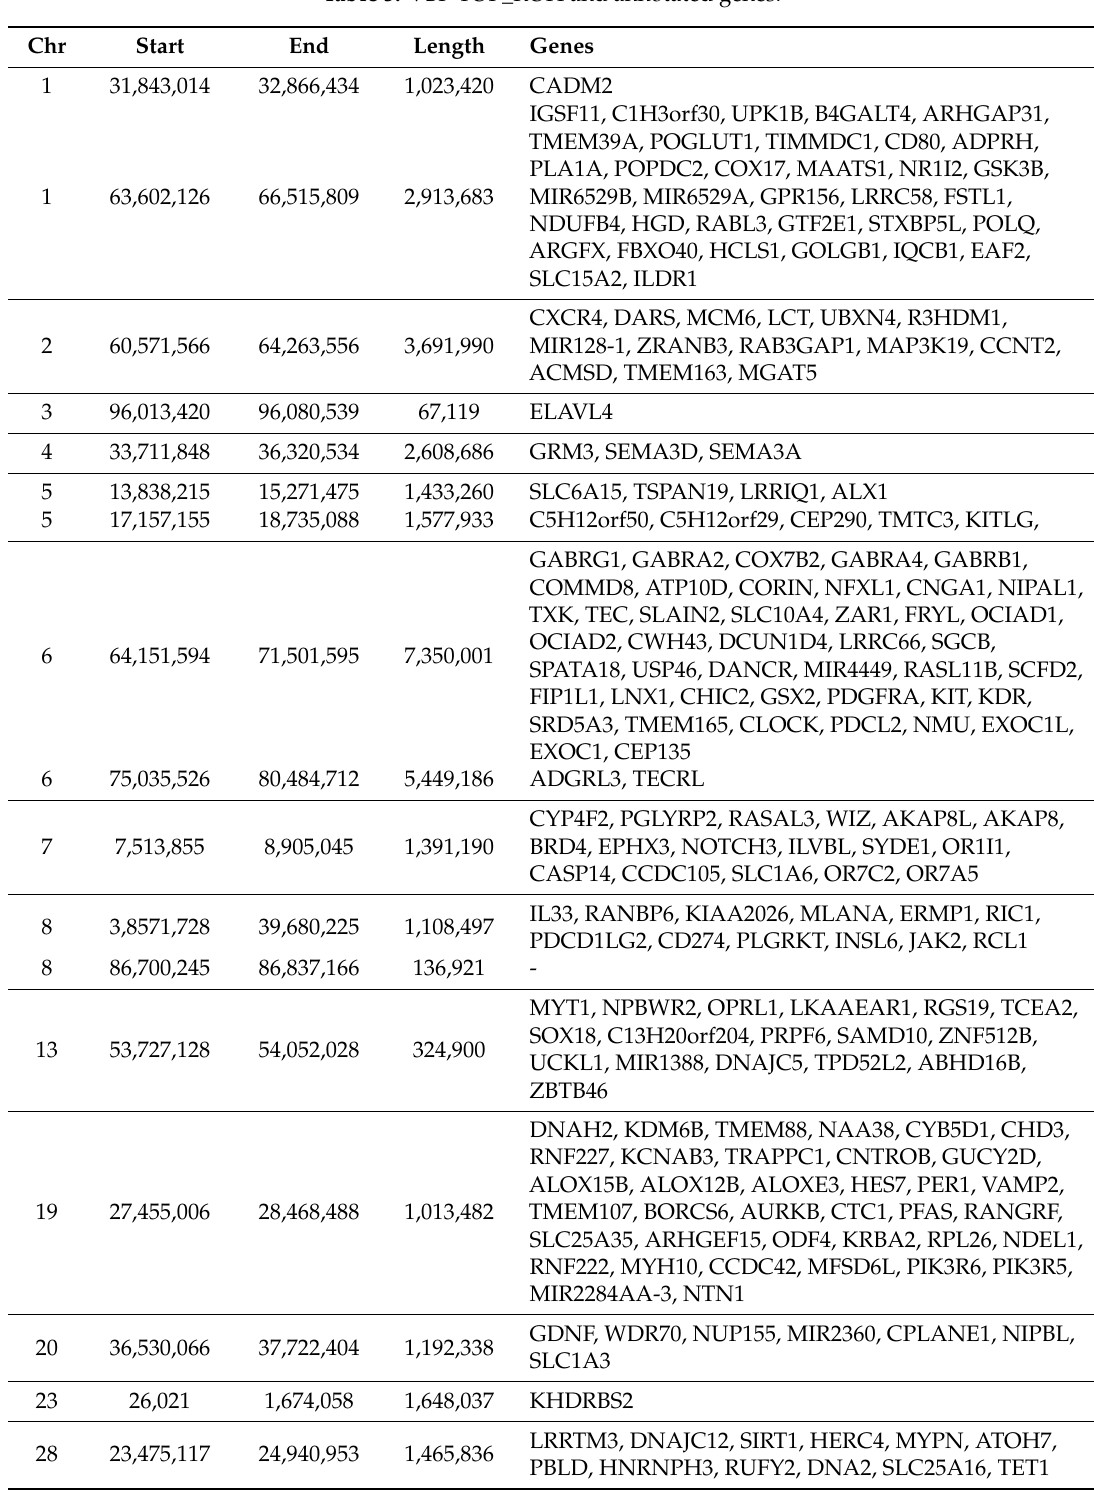
Table 3. VBP TOP_ROH and annotated